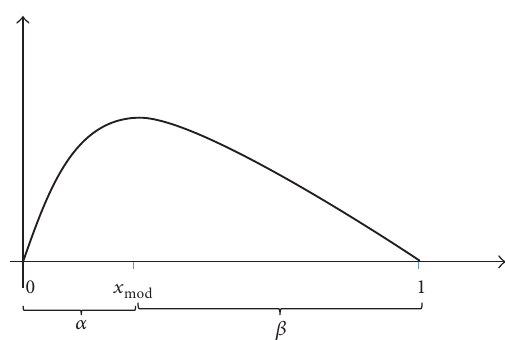
Figure 1: 𝛼 < 𝛽 and so the curve has positive